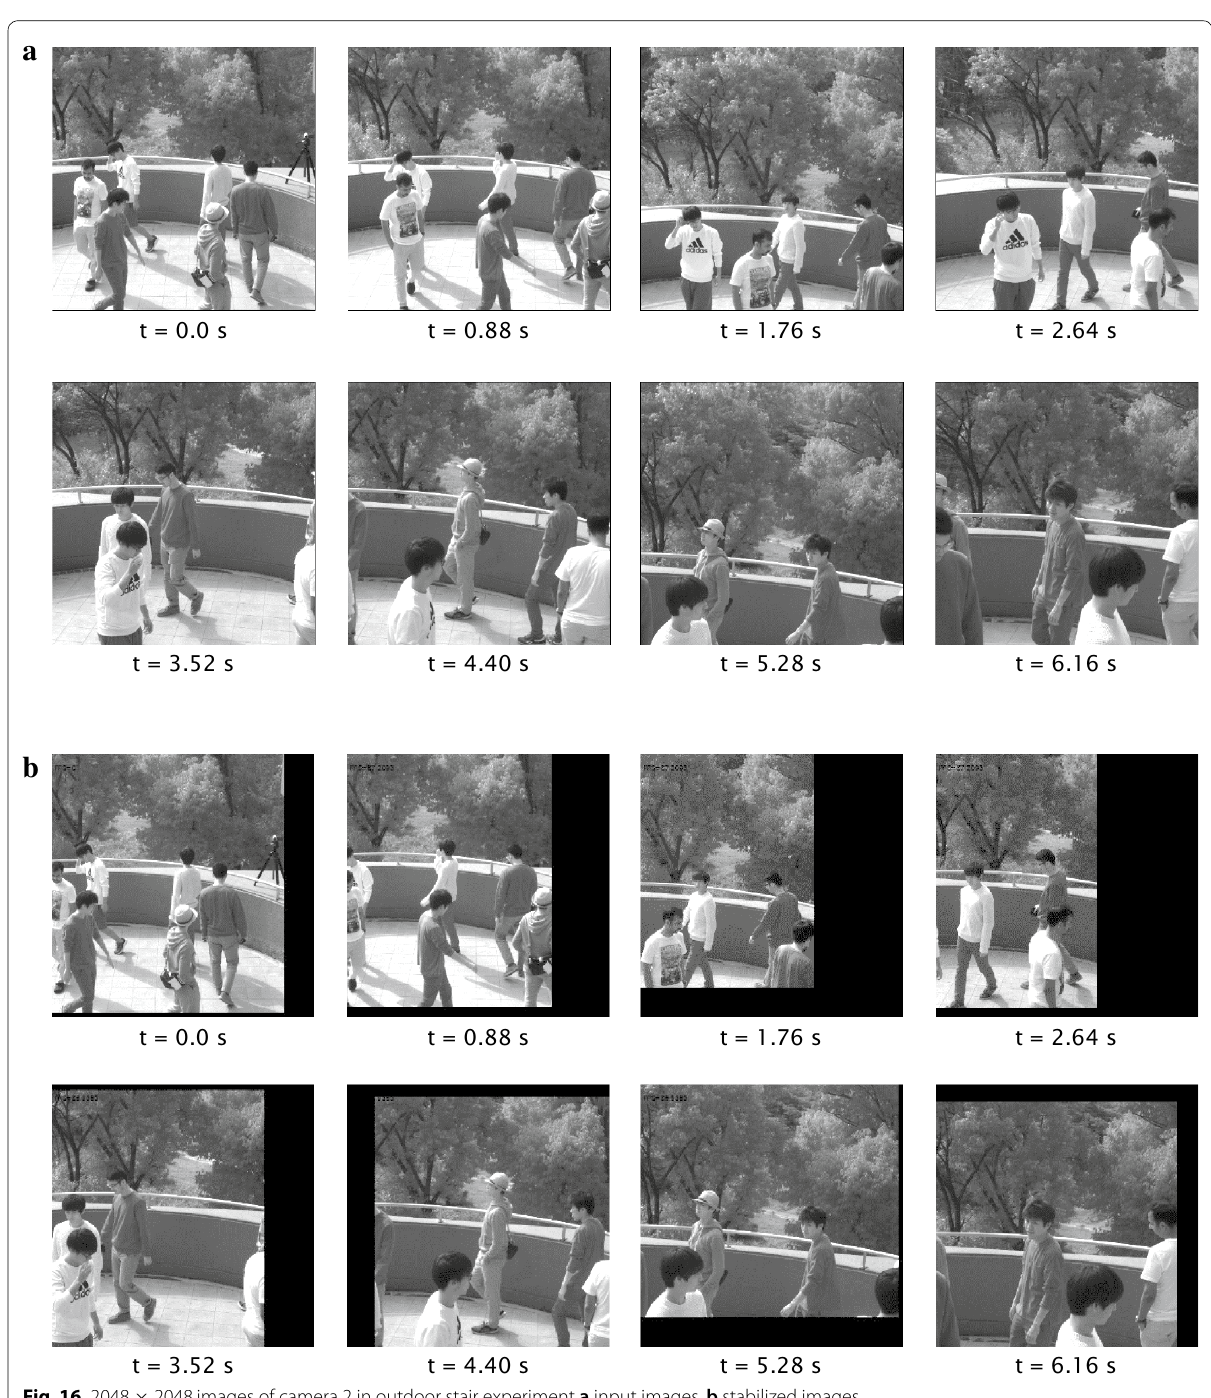
Fig. 16 2048 × 2048 images of camera 2 in outdoor stair experiment a input images, b stabilized